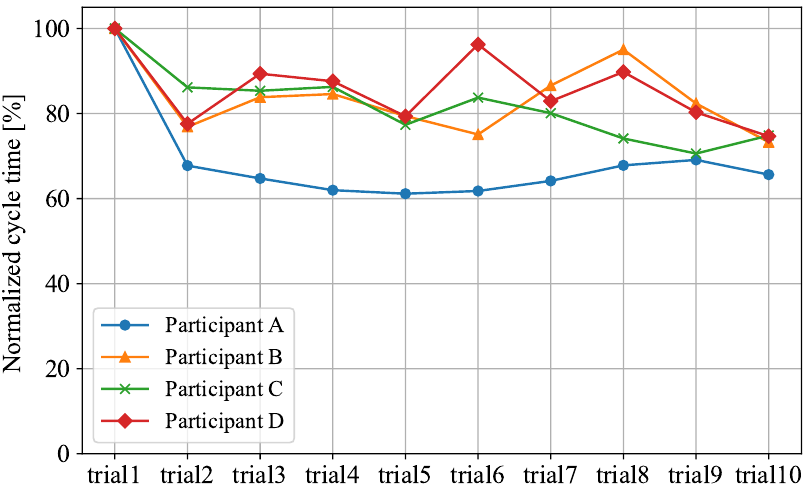
Figure 8. Comparison of Cycle